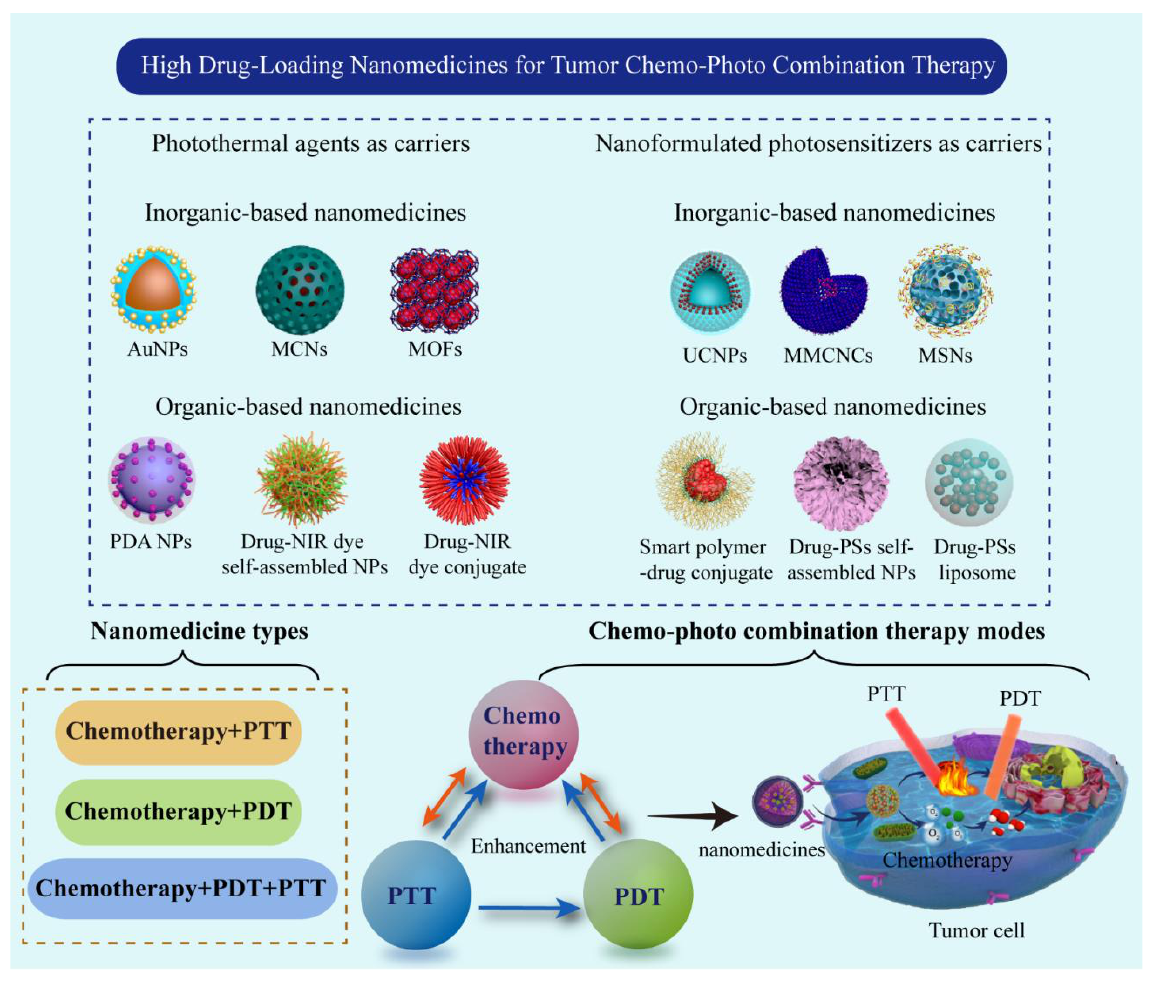
Figure 1. Schematic illustration of this review. AuNPs, gold nanoparticles; MCNs, mesoporous carbon nanospheres; MOFs, metal–organic frameworks; UCNPs, upconversion nanoparticles; MMCNCs, mesoporous magnetic colloidal nanocrystal clusters; MSNs, mesoporous silica nanoparticles.